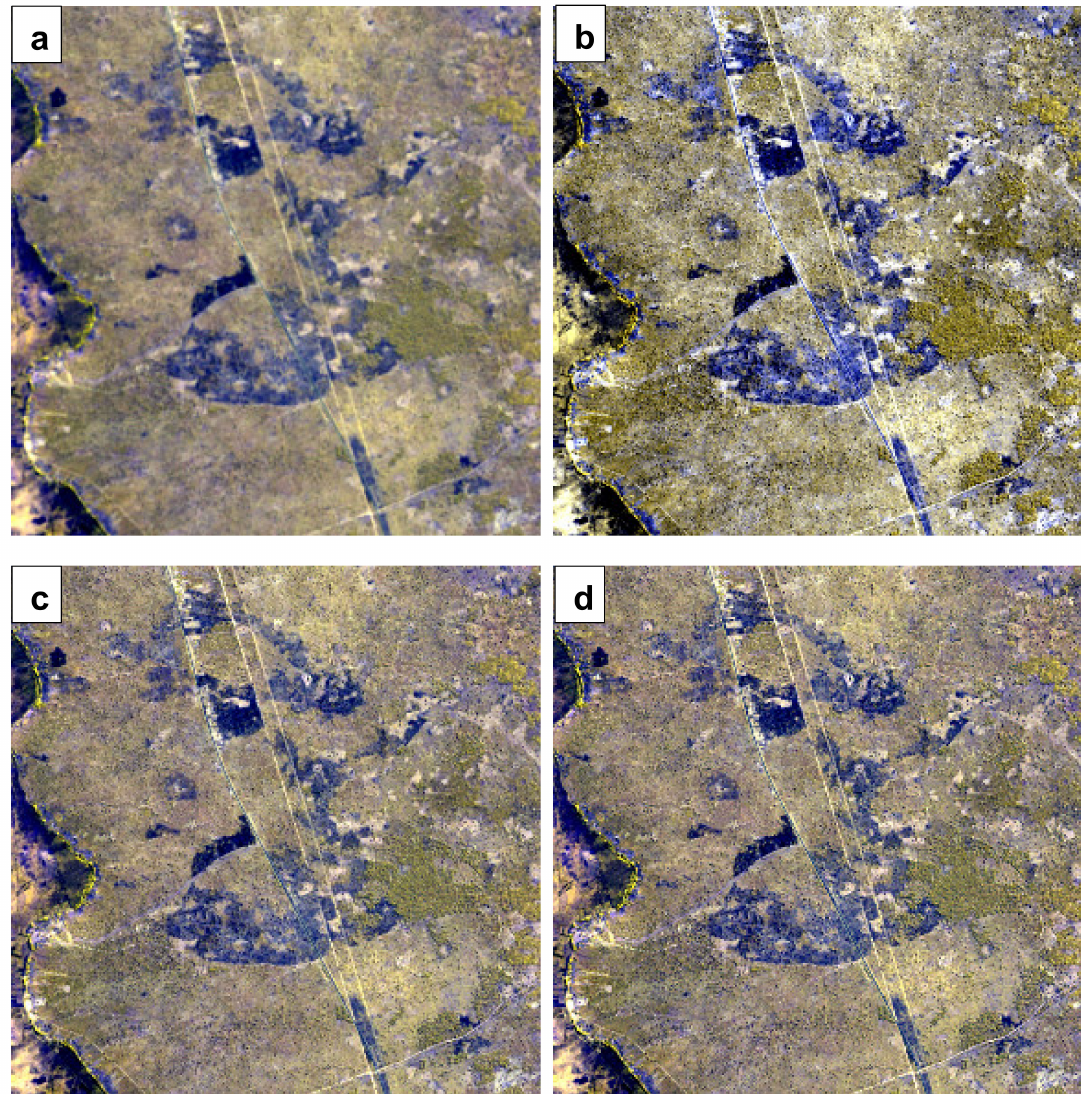
Figure 5. Study site 2 false color surface reflectance images, composed of 1800 × 1800 3.333 m pixels covering 6 × 6 km ( a ) Sentinel-2 NIR (855–875 nm), red-edge (773–793 nm), and SWIR (1565–1655 nm) reflectance bilinear resampled from 20 m, ( b ) Planetscope NIR reflectance and synthetic Sentinel-2 red-edge and SWIR reflectance, ( c ) Sentinel-2 false color reflectance HPM sharpened from 20 m, and ( d ) Sentinel-2 false color reflectance M3 sharpened from 20 m. Images oriented with north at the top of the image. Site and image dates summarized in Table